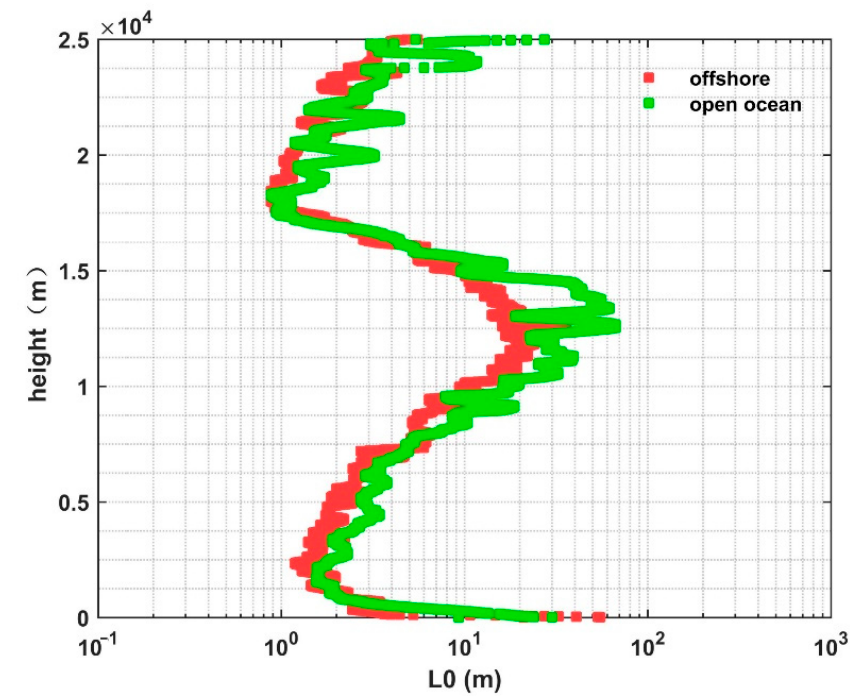
Figure 7. Statistically averaged outer scale profiles of offshore and open ocean.